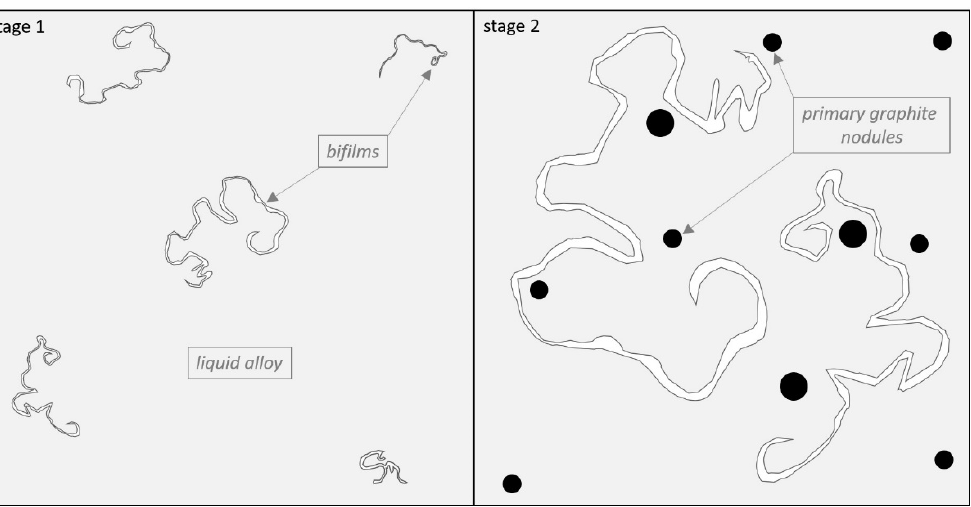
Figure 6. Bifilms in the liquid alloy ( stage 1 ). Graphite crystallization directly from the liquid ( stage 2 ).